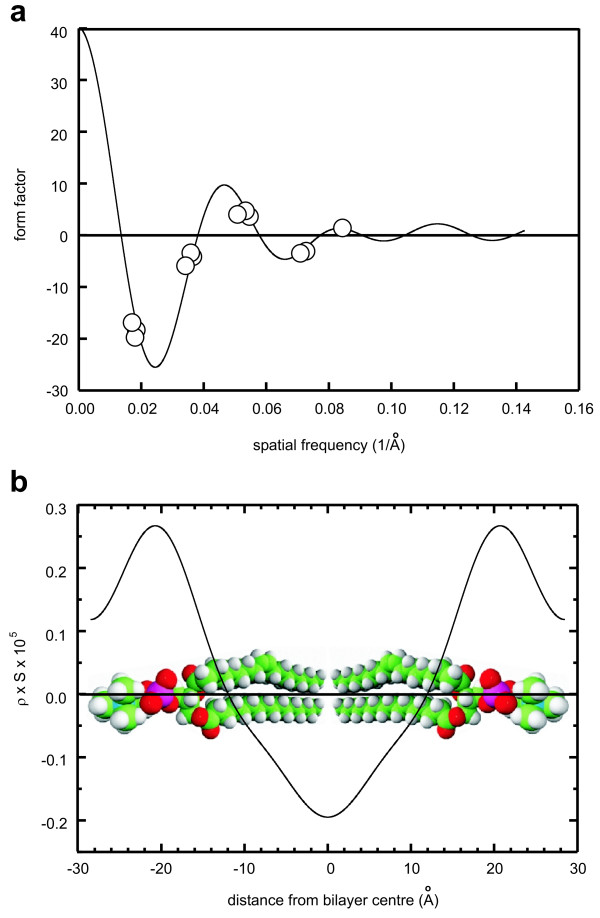
Calculation of bilayer scattering length density profiles from neutron diffraction data. Panel a shows structure factors obtained from POPC/Chol (70:30 mol%) membranes, and fitting to a continuous transform for phase determination (- - + - + for orders #1–5 in this example). The data points (open circles) include measurements at up to 3 different relative humidities (i.e. 3 different lamellar spacings). Panel b shows the scattering length density (SLD) profile calculated by Fourier synthesis using the signed form factors obtained in part a, after scaling the data to match the mean scattering length of the bilayer unit cell. The main features of the centrosymmetric profile, corresponding to the space-filling model of POPC, are described in detail in the text.